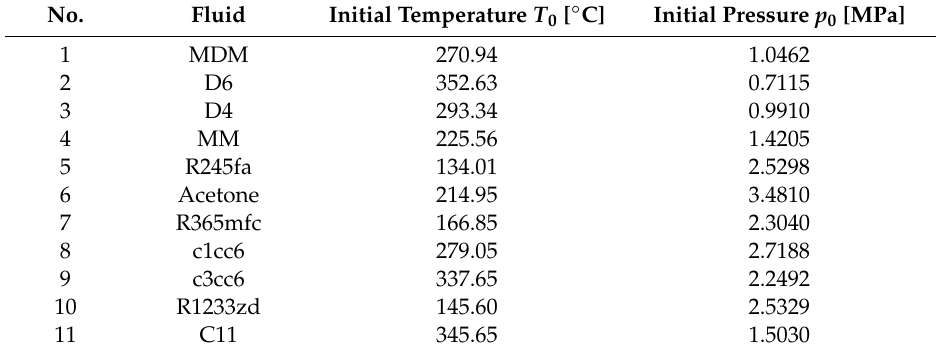
Table 1. Initial temperatures and pressures for di ff erent working media for cycle variant 1 (cycle with saturated live vapor and a regenerator for warming up the working fluid).